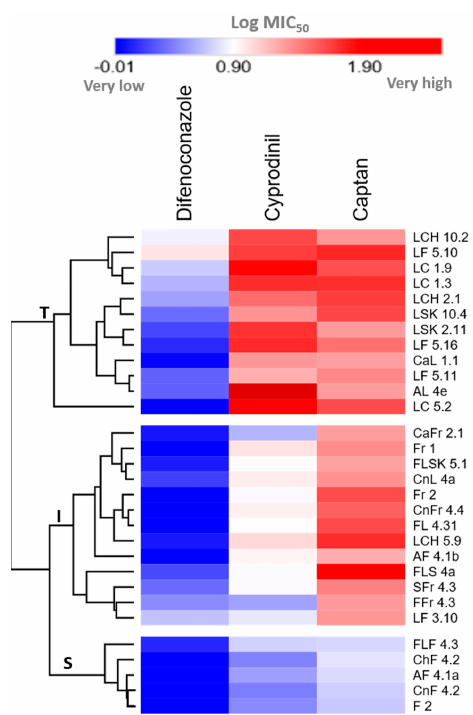
Figure 6. Clustering of the 30 A.pullulans isolates into tolerant (T) and sensitive (S; to one or two, or all three fungicides used here) isolates. The dendrogram was plotted using the hierarchical complete linkage clustering method (distance between clusters measured using the Euclidean distance) for the log MIC 50 values for the three fungicides. The distributions of the sensitivities in the respective clusters based on log MIC 50 values are highlighted in the heat map. S = sensitive (to all three fungicides), I = intermediate (sensitive to DFN and tolerant to one or two fungicides), and T = tolerant (insensitive to all the three fungicides or to CPN and